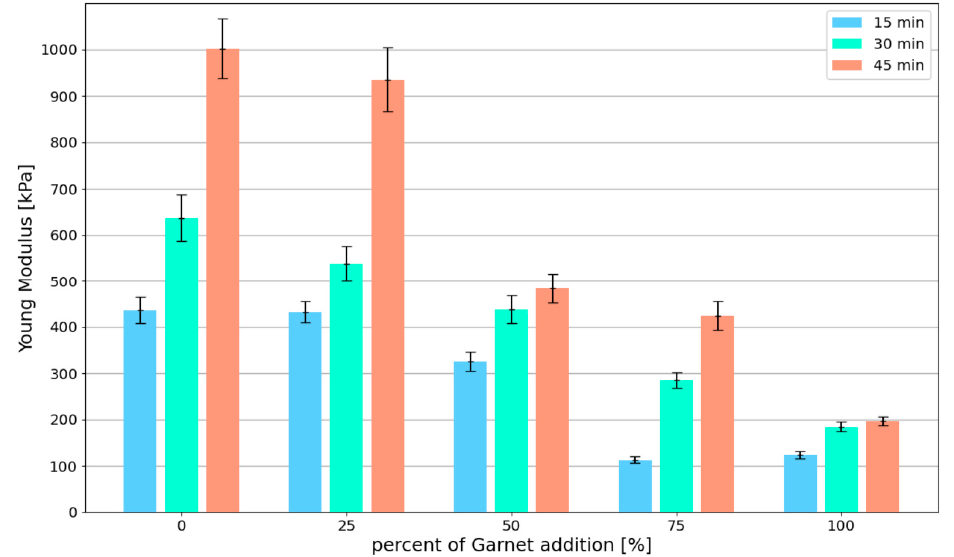
Figure 15. Relationship between the stiffness and garnet